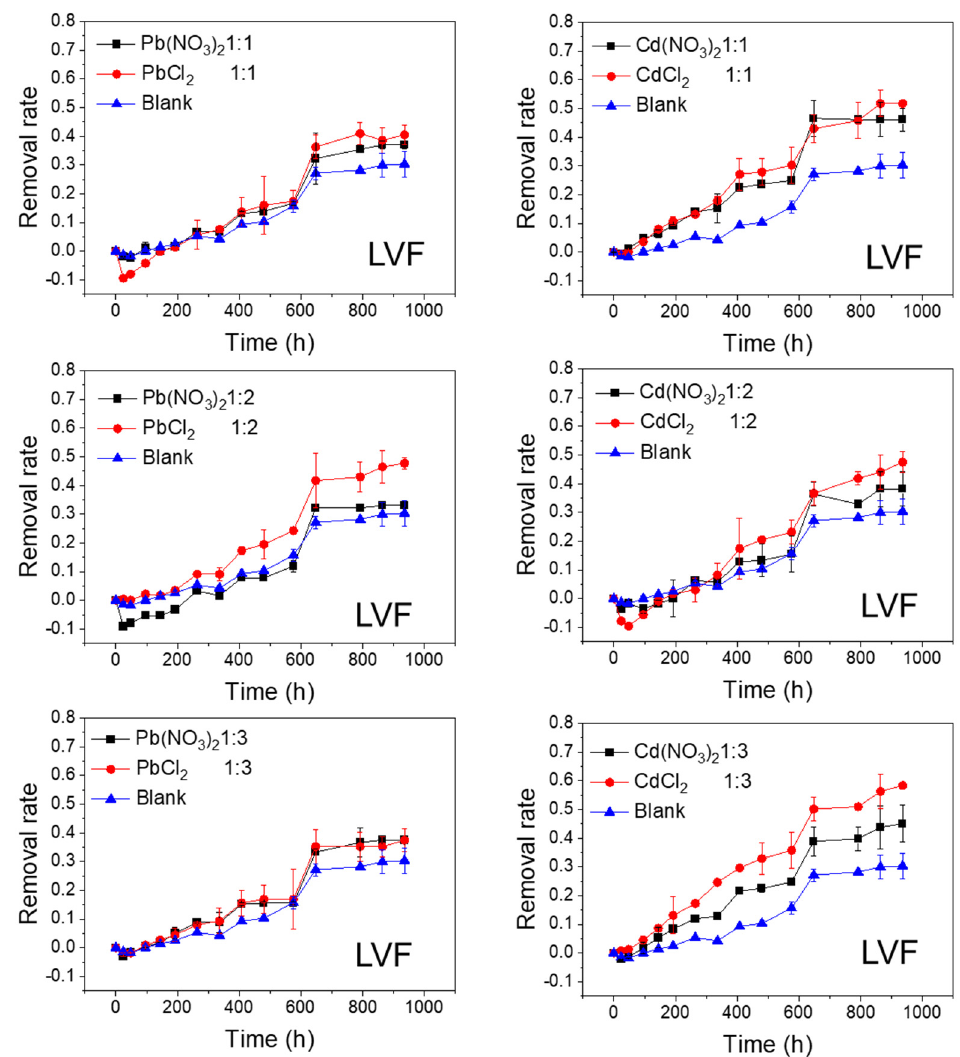
Figure 5. Photolytic degradation of LVF (0.012 mmol/L) with the effects of NO 3 − and Cl − at different molar ratios; Blank means no heavy metal ions added.